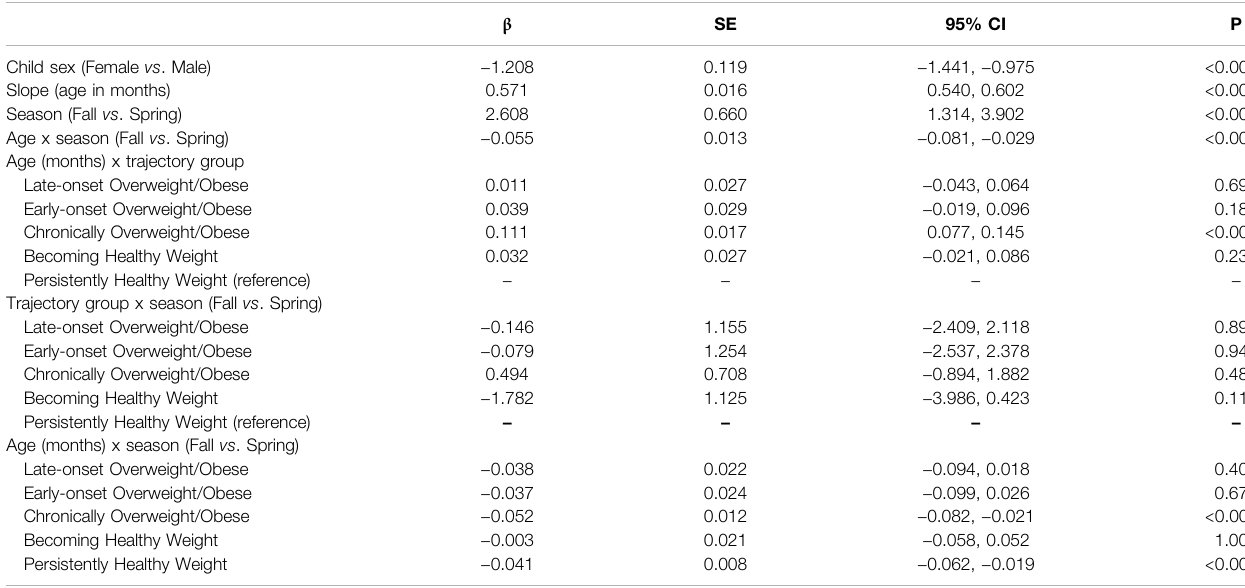
TABLE 2 | Mixed model fi ndings for effect of season on the outcome of height (cm). β SE 95% CI P Child sex (Female vs .